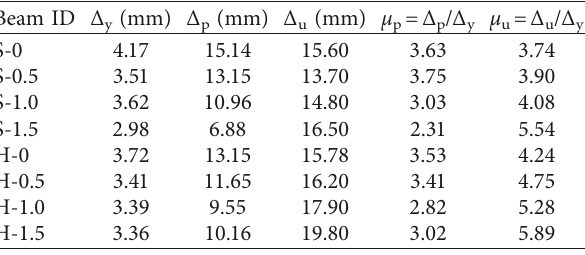
Table 4: Ductility indices of the solid and hollow tested beams.